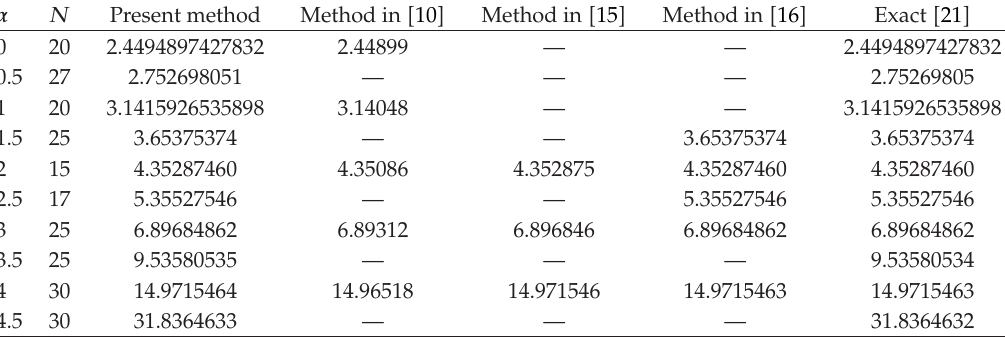
Table 3: Comparison of numerical results for ξ (cid:3) y (cid:3) ξ (cid:4) (cid:5) 0 (cid:4) for Example 4.2.